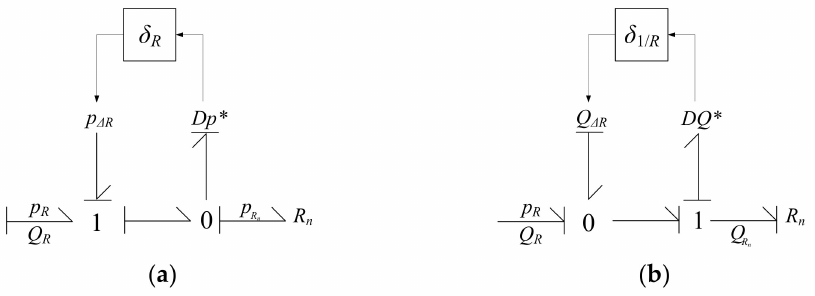
Figure 8. BG-LFT model of resistive element: ( a ) impedance type; ( b ) admittance type.